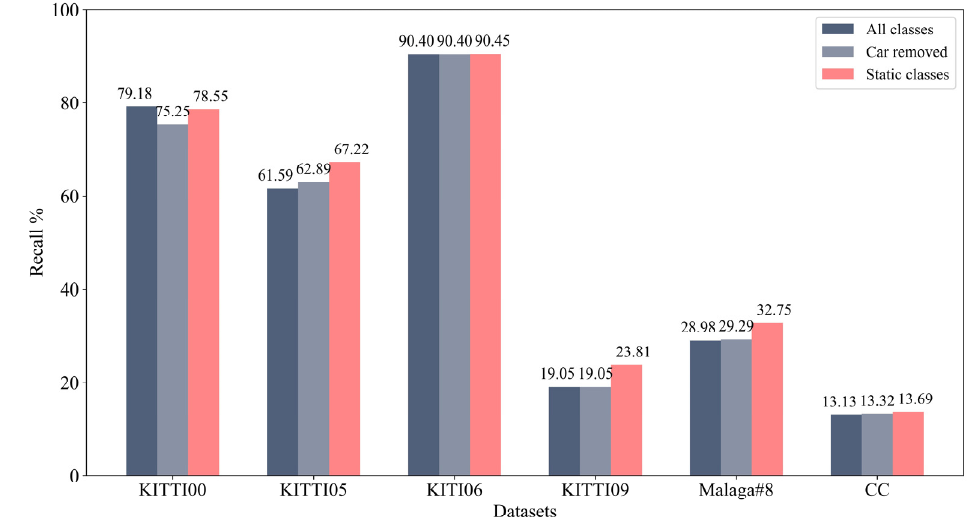
Figure 4. Effect of semantic categories on six datasets.